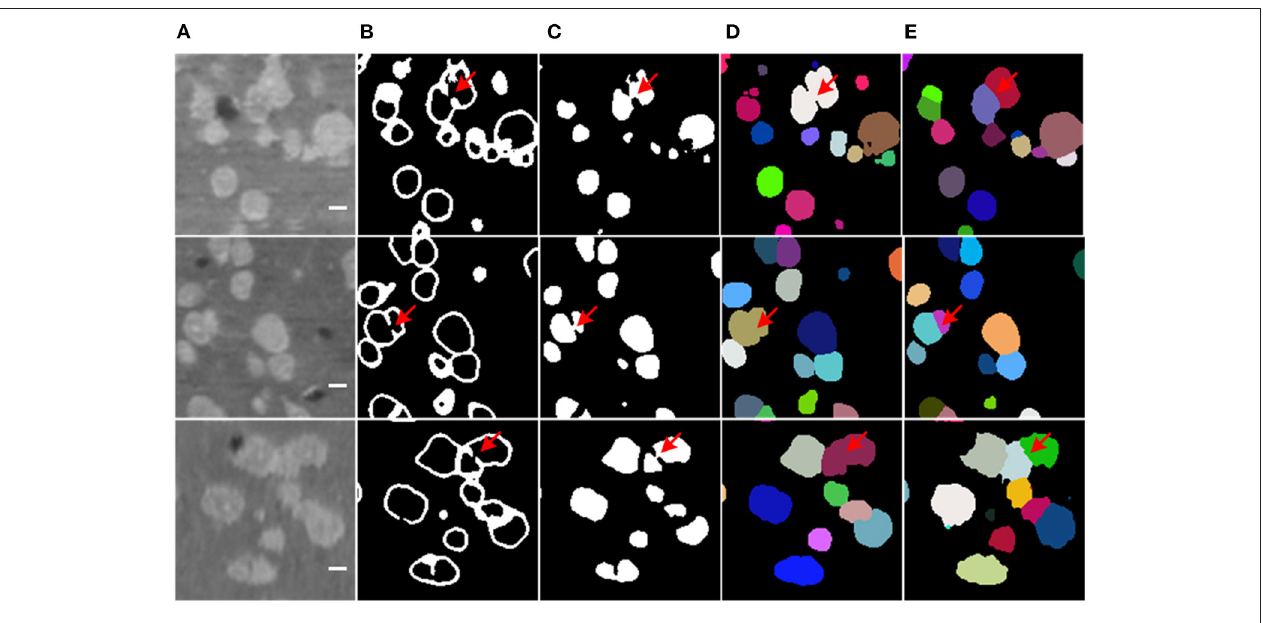
FIGURE 9 | Missing boundary in results. (A) Slices from raw volumetric data. (B) Predicted mask of boundary. (C) Predicted mask of neuronal soma. (D) Segmentation result labeled by random unique color. (E) Ground truth. The shape of slices is 150 × 150 voxels, the bar indicates 5 µ m, and the red arrows label the local missing